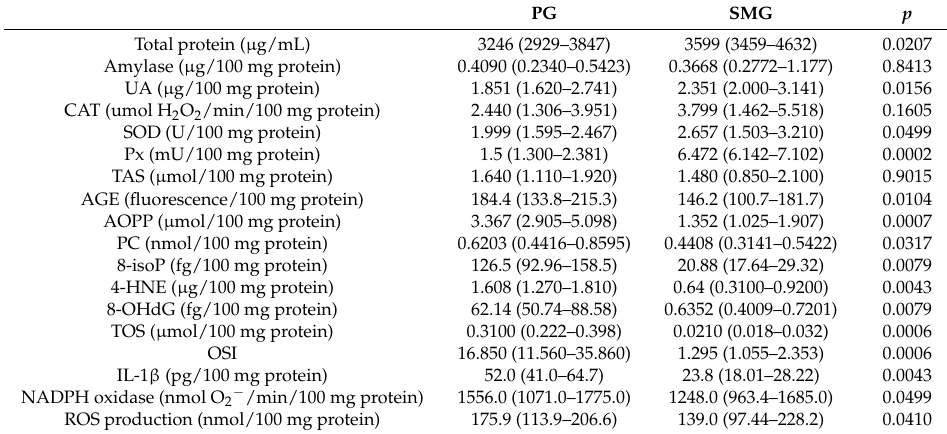
Table 3. Differences between submandibular and parotid glands of high-sucrose diet (HSD) fed